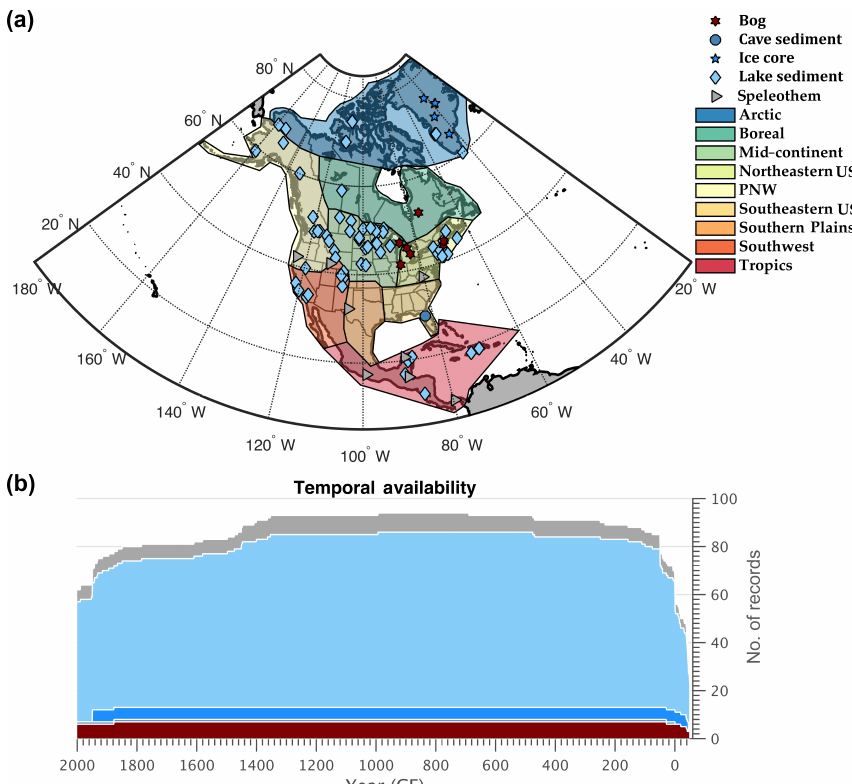
Figure 1. Temporal and spatial distribution of the North American paleo-hydroclimate records used in this study. Panel (a) shows the geographical distribution by archive type indicated by symbol colors and shapes. The differently colored areas on the map delimit the regions used for principal component analyses (e.g., PNW, Pacific Northwest). Panel (b) shows the temporal distribution of records in the dataset. Colors correspond to the archive types in the